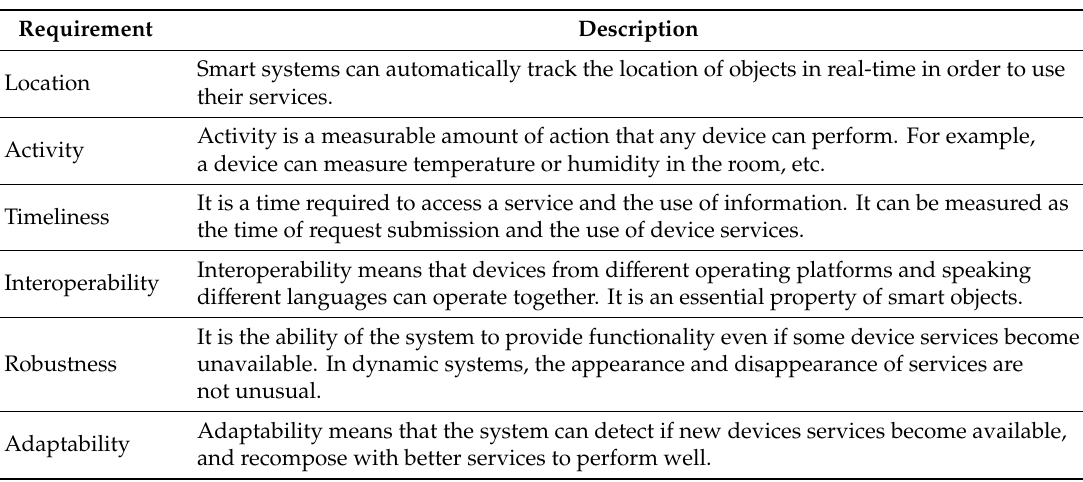
Table 2. Smart system’s specific